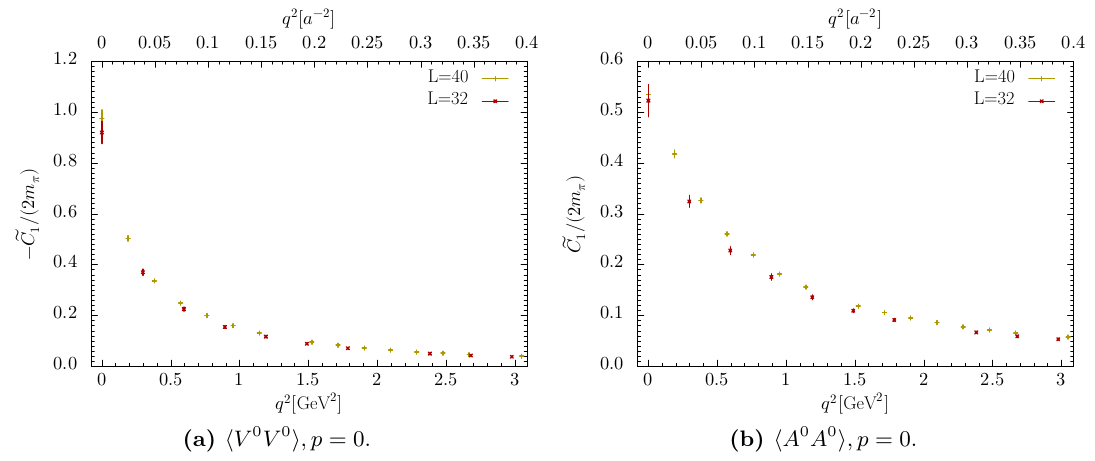
Figure 17. Volume comparison of the Fourier transform e C 1 for light